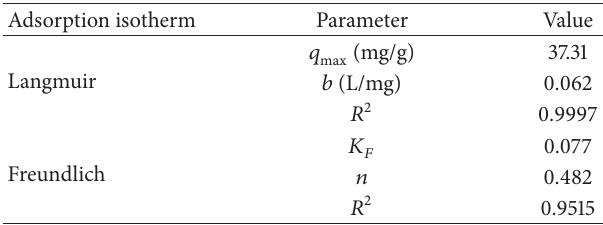
Table 2: Langmuir and Freundlich constants for Pb(II) adsorption using activated